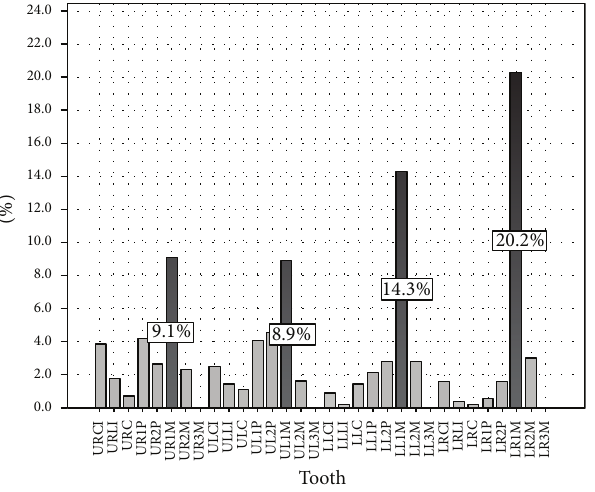
Figure 4: Distribution of endodontically treated teeth [UR: upper right, UL: upper left, LR: lower right, LL: lower left, CI: central incisor, LI: lateral incisor, C: canine, 1P: first premolar, 2P: second premolar, 1M: first molar, 2M: second molar, and 3M: third molar]. Figure 2: Overall procedural errors.